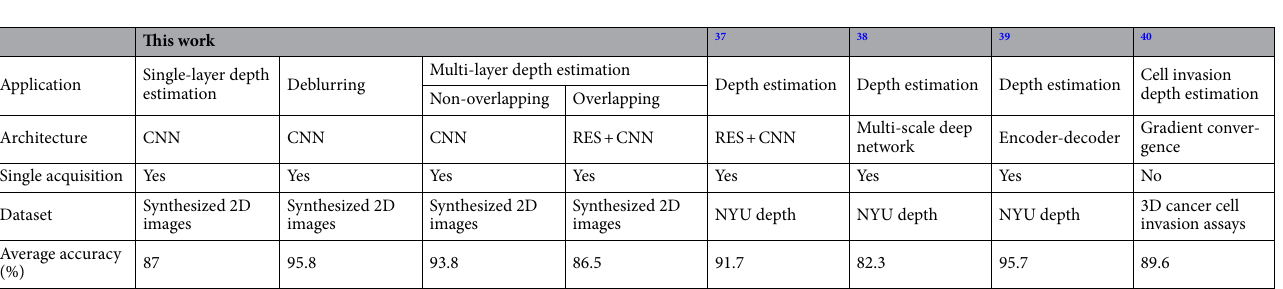
Table 1. Comparison of this work with current depth estimation